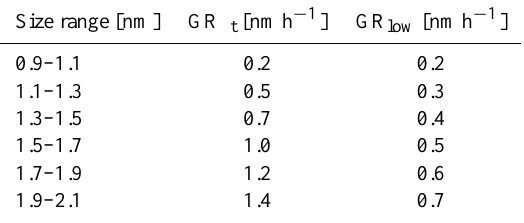
Table 1. Growth rates for different size classes between 0.9 and 2.1nm. GR fit shows the growth rates obtained by fitting a third- degree polynomial to experimental data, and differentiating. GR low shows the growth rates used for analyzing the sensitivity of the re- sults to the changes in the growth